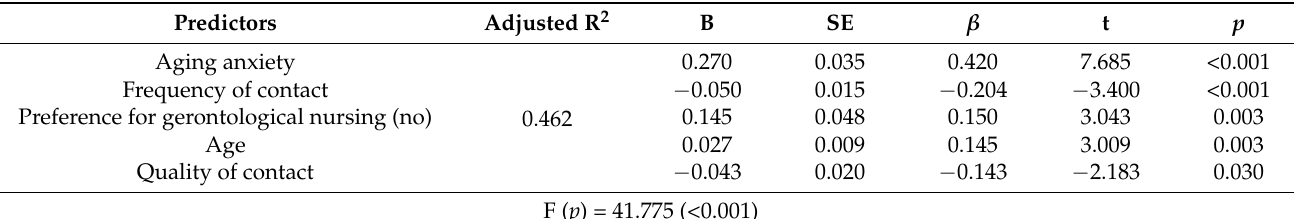
Table 5. Stepwise multiple regression model for predictors of ageism ( N =